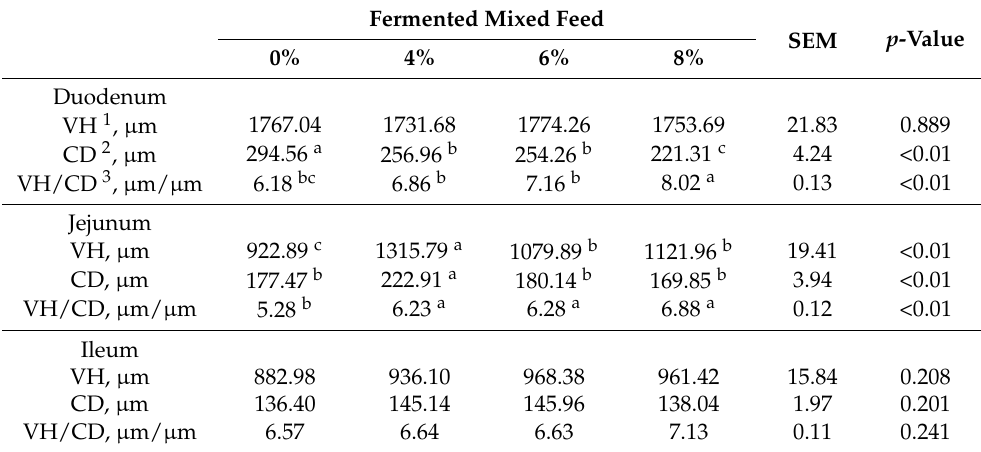
Table 4. Effect of fermented mixed feed on intestinal morphology in laying